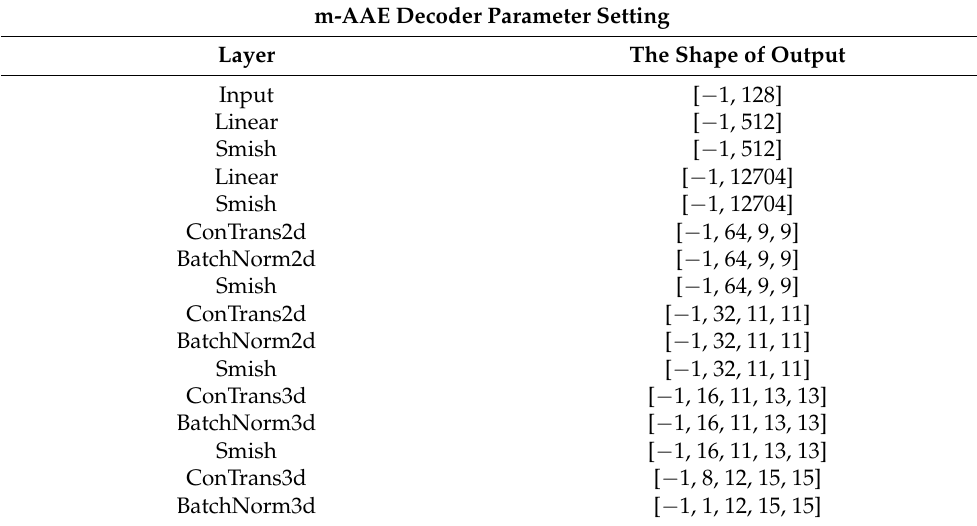
Table 5. The shape of layers in the m-AAE model for decoding.